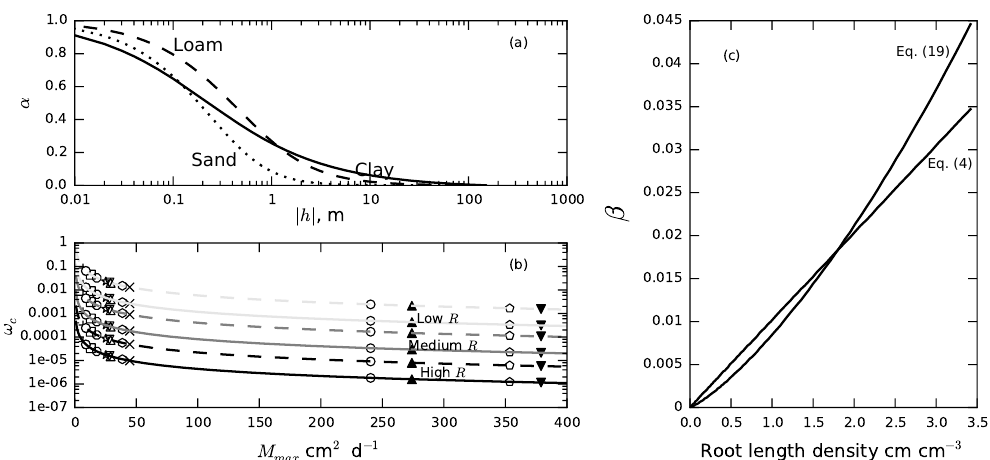
Figure 9. (a) α of the JMII model (Eq. 18) as a function of soil pressure head h s , (b) ω c parameter (Eq. 20) for different soil types (the three soil types used in the simulations and soils from Wösten et al., 1999), expressed by M max , and (c) the normalized root length density β computed by Eqs. (4) (JMf) and (19) (JMII) as a function of root length density R , given by Eq. (30) with R avg = 1 . 0cmcm − 3 and b = 2.